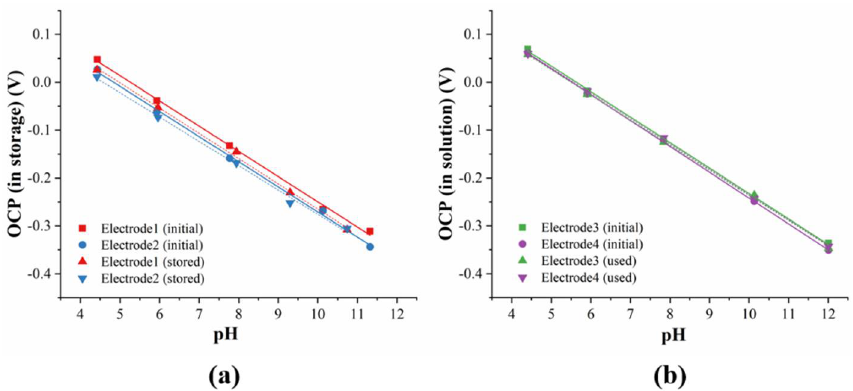
Figure 11. Involution in the sensitivity of the electrodes ( a ) after storage for 60 days and ( b ) when utilized in PBS for 30 min.